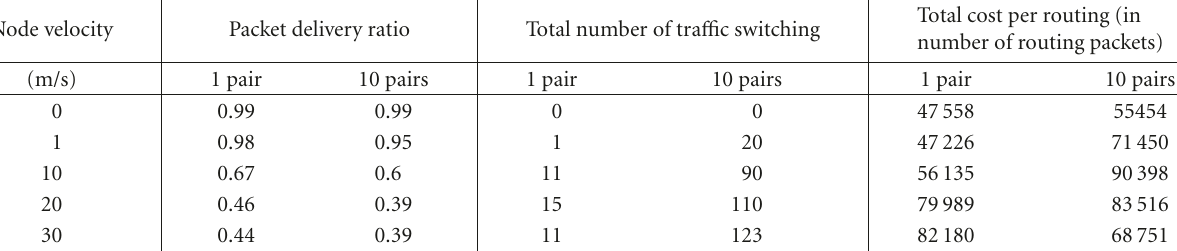
Table 2: Performance results of routing and data delivery.